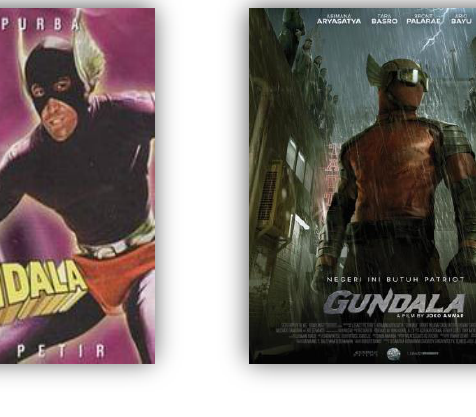
Figure 8.1 st Gundala Movie in Figure 9. Remake of Gundala 1981 Movie in 2019 by Joko by Lilik Sudjio